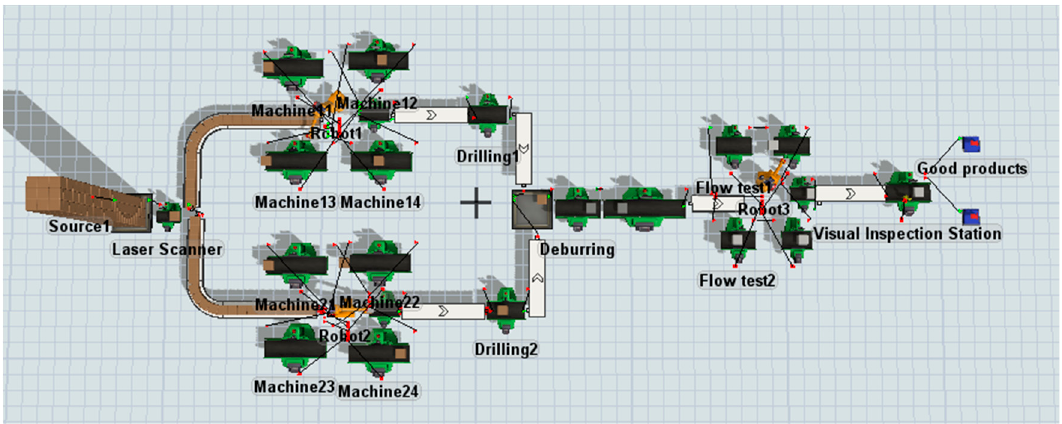
Figure 6 . Model of robotic line. Figure 6. Model of robotic